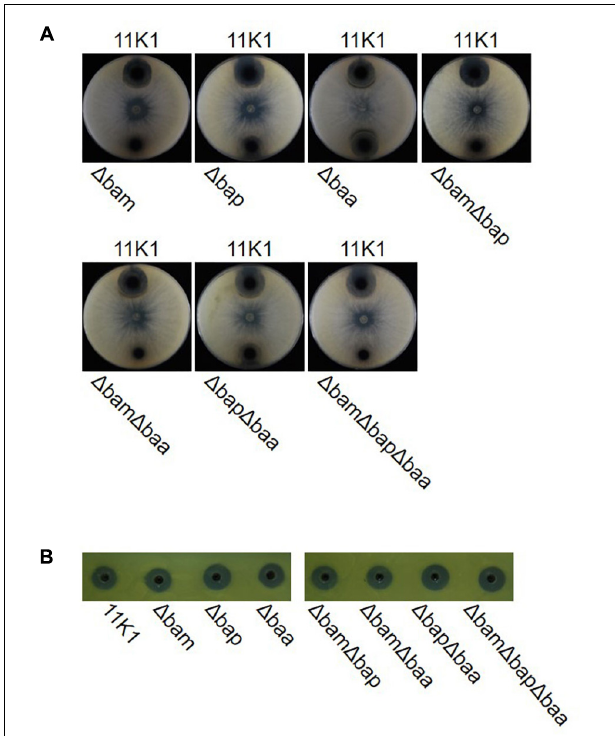
FIGURE 3 | (A) Antimicrobial activity of Pseudomonas sp. 11K1 and its mutants against Botryosphaeria dothidea , and (B) Xanthomonas oryzae RS105. B. dothidea disks (5 mm diameter) were placed in the center of each plate and 5 µ L of an overnight culture of wild-type (WT) 11K1 or its mutants were inoculated near the edge of PDA medium plates. For antibacterial assays, 50 µ L of sterile fermentation liquor was used to detect bacterial inhibition. (cid:49) bam, brasmycin gene cluster deletion mutant; (cid:49) bap, braspeptin gene cluster deletion mutant; (cid:49) baa, brasamide gene cluster deletion mutant; (cid:49) bam (cid:49) bap, brasmycin and braspeptin double gene cluster deletion mutant; (cid:49) bam (cid:49) baa, brasmycin and brasamide double gene cluster deletion mutant; (cid:49) bap (cid:49) baa, braspeptin and brasamide double gene cluster deletion mutant; (cid:49) bam (cid:49) bap (cid:49) baa, brasmycin, braspeptin, and brasamide triple gene cluster deletion